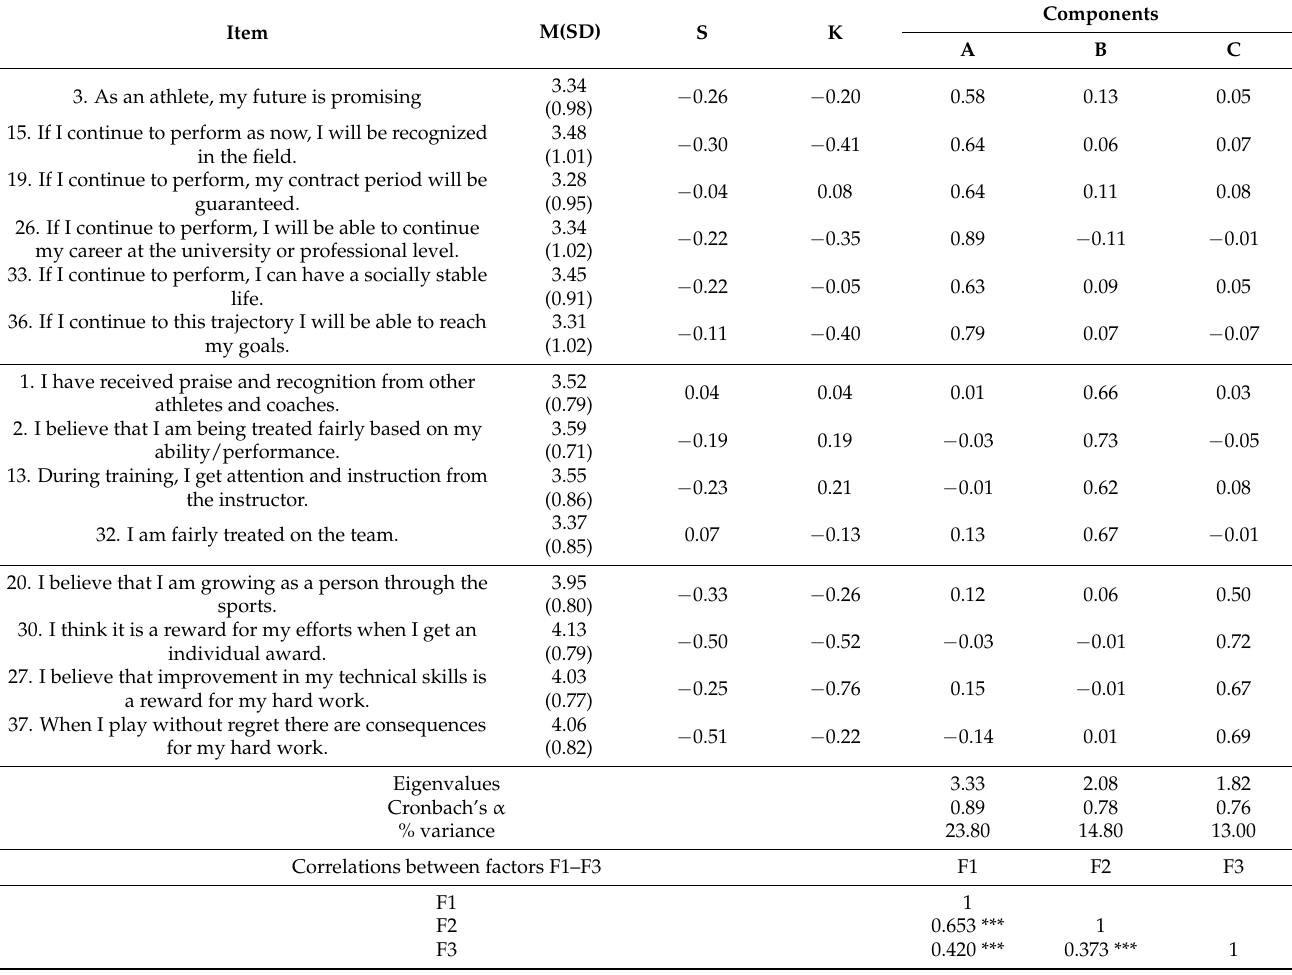
Table 2. The extracted factors from